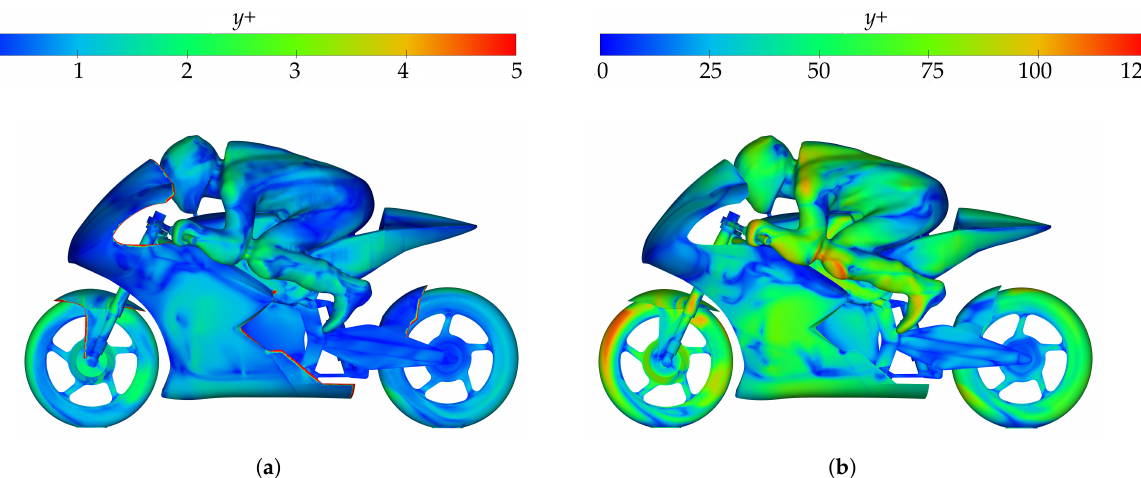
Figure 3. Contours of the y + values for the mesh with ( a ) near-wall model approach and ( b ) wall- function approach.